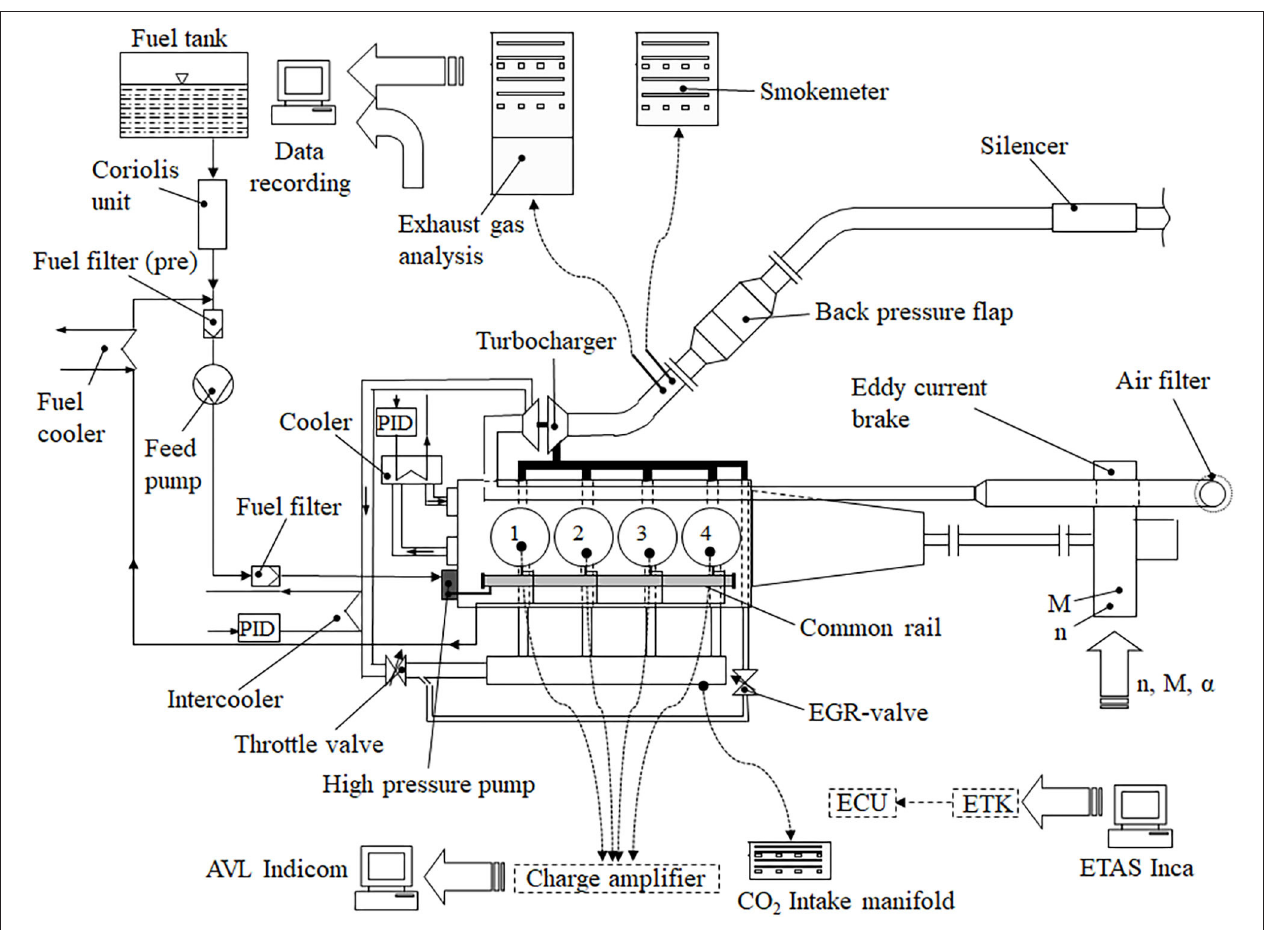
FIGURE 2 | Experimental set up of the engine test bench (Moeltner et al.,